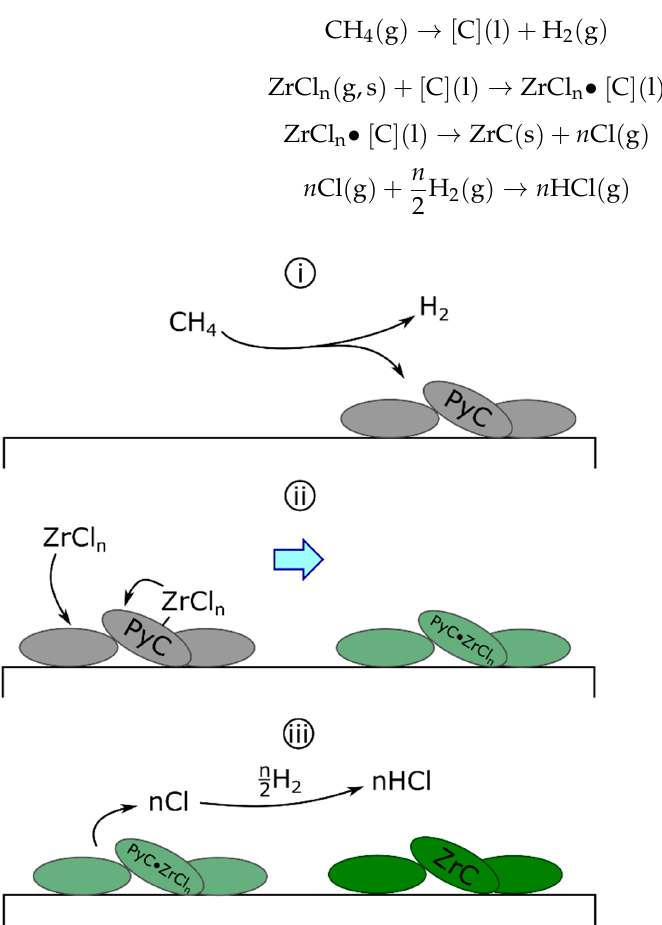
Scheme 2. The deposition of ZrC by the droplet mechanism. ( i ) PyC droplets deposit on the sub- strate surface. ( ii ) Surface-bound or gaseous zirconium chlorides diffuse into droplets. ( iii ) Atomic chlorine evolves from the droplets, forming ZrC—atomic chlorine reacts with hydrogen to form